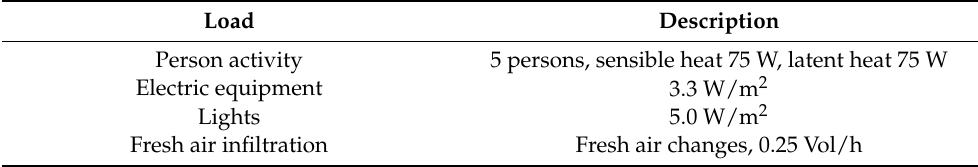
Table 3. Internal thermal loads of the